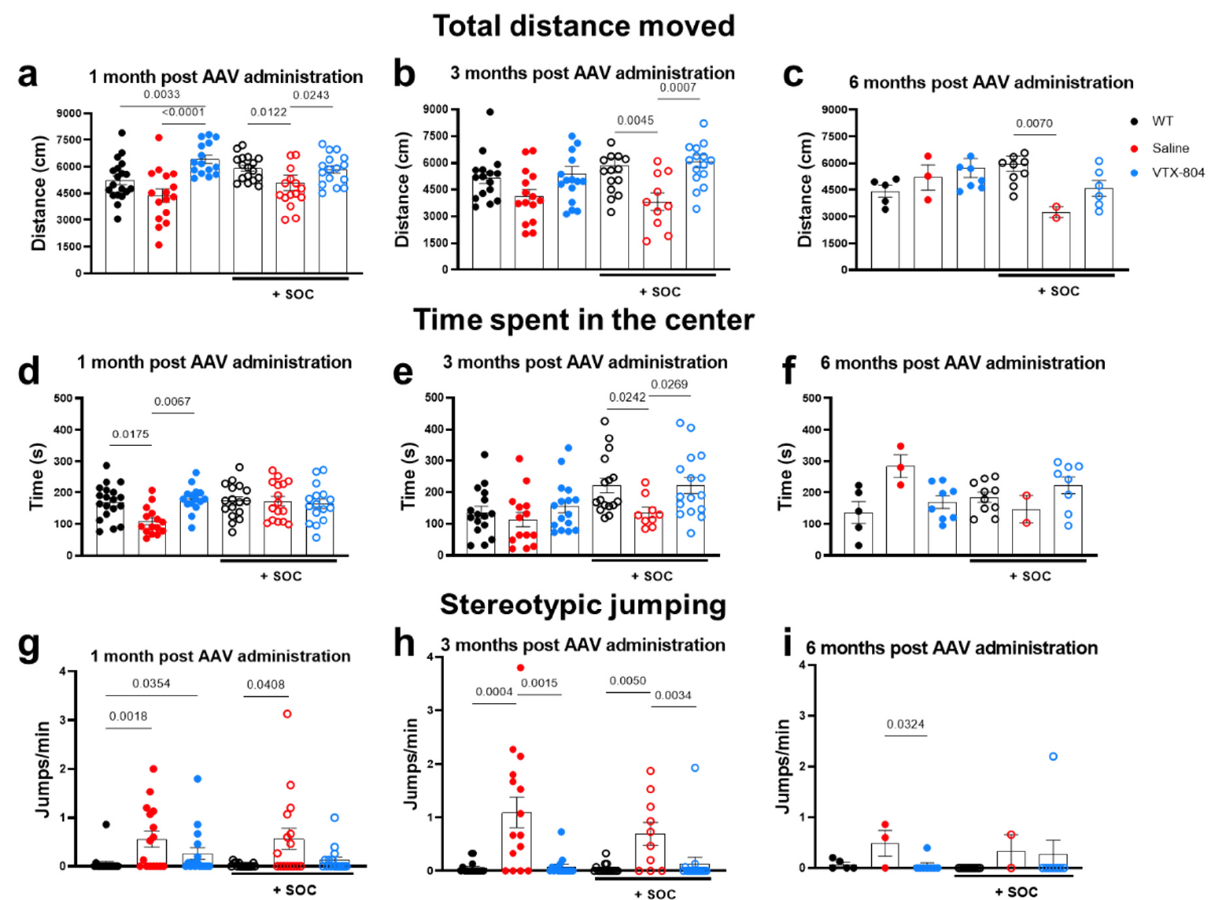
Figure 4. Open field test. Ass1 fold mice treated with VTX-804 vector with or without nitrogen scavenger treatment from birth to weaning (SOC) were subjected to the open field test one, three and six months after vector administration. The following parameters were analyzed: total distance moved ( a – c ) and thigmotaxis to quantify the time spent at the center of arena ( d – f ). In addition, the number of hopping stereotypes (jumps/min) were quantified at the same time points ( g – i ). Group of animals without SOC treatment: Ass1 fold treated with VTX-804 vector only (blue closed circles; n = 16), saline treated Ass1 fold mice (red closed circles; n = 16) and healthy WT mice (black closed circles; n = 19). Group of animals with SOC treatment: Ass1 fold treated with VTX-804 vector (blue open circles; n = 16). Controls included saline treated ASS1 fold mice (red open circles; n = 16) and healthy WT mice (black open circles; n = 19). Some groups were composed of a different number of animals at different measurements due to technical inconsistencies when they were studied and, in the saline group, as consequence of deaths. Half of mice were sacrificed 3 months after vector administration and consequently the six months Wt and VTX-804 groups comprised less animals. Only p < 0.05 values are presented (one-way ANOVA with Bonferroni multiple comparisons test or Kruskal-Wallis with uncorrected Dunn’s